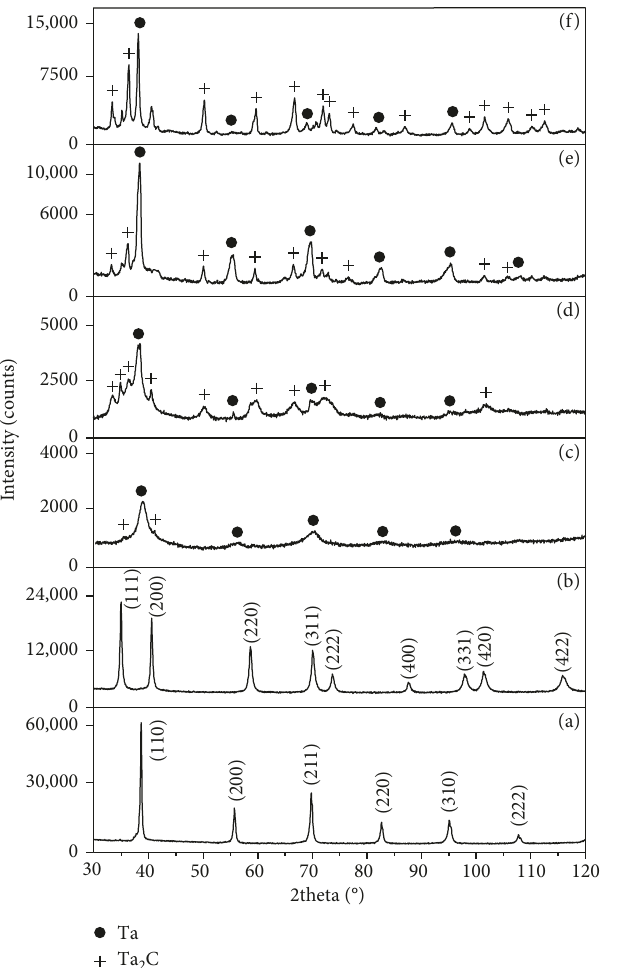
Figure 3: XRD of the pure Ta (a) and TaC (b) powders; Ta-5TaC (c) and Ta-40TaC (d) nanocomposites’ powder mixture after mechanical alloying; and Ta-5TaC (e) and Ta-40TaC (f) bulk nanocomposites after